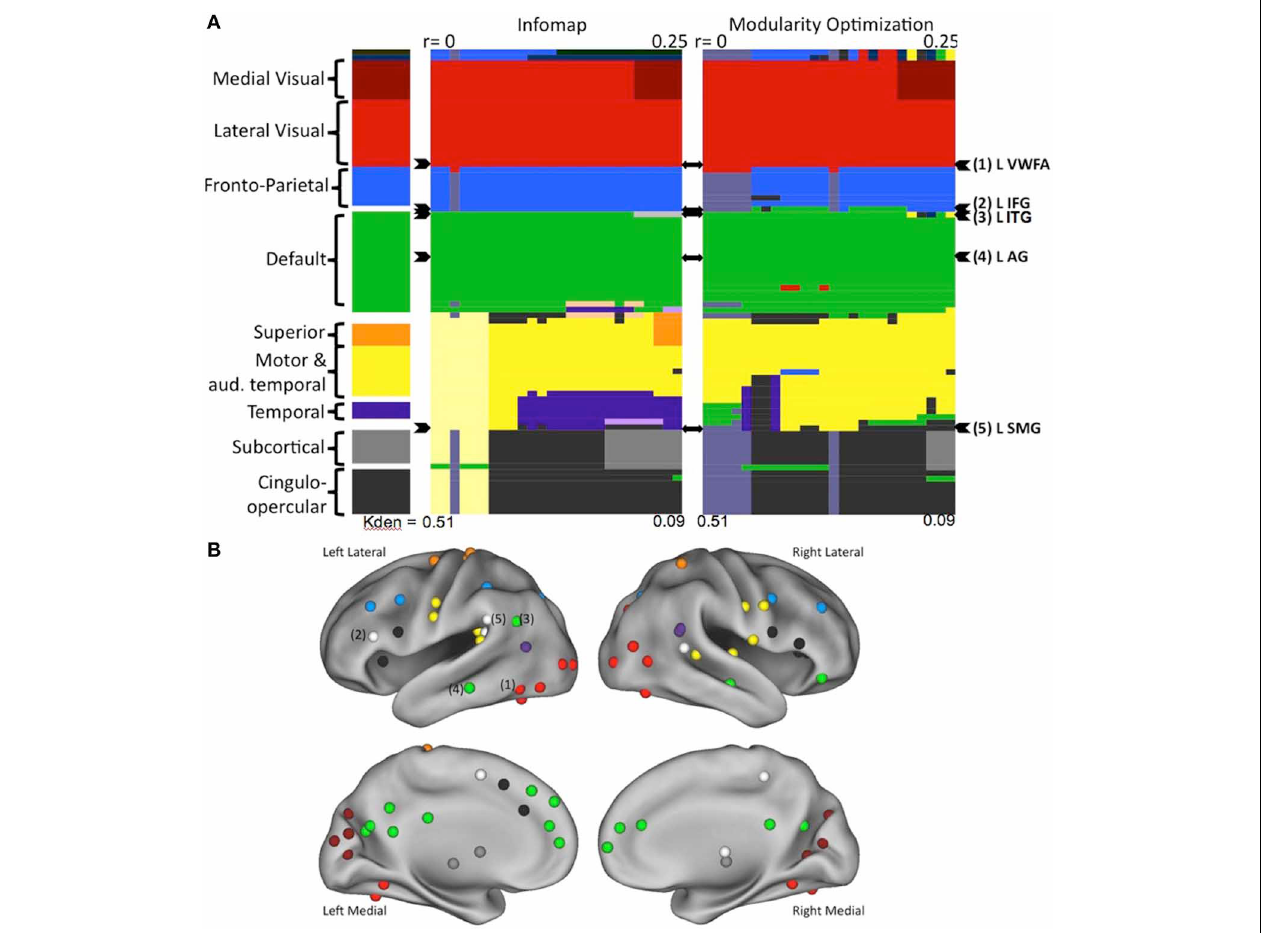
FIGURE 4 | Regions thought to be used predominantly in reading do not formareadingcommunityinlargescalenetworkanalyses.(A) Thenetwork organization of all regions activated during reading. Communities were defined using two separate algorithms, the results for Infomap shown on the left and Modularity Optimization shown on the right. In each case, communities were defined across a range of RSFC correlation thresholds. Each RSFC correlation threshold corresponds to a column in the color plot. Each individual region is denoted by a row. The classification of each region is shown as the color of the